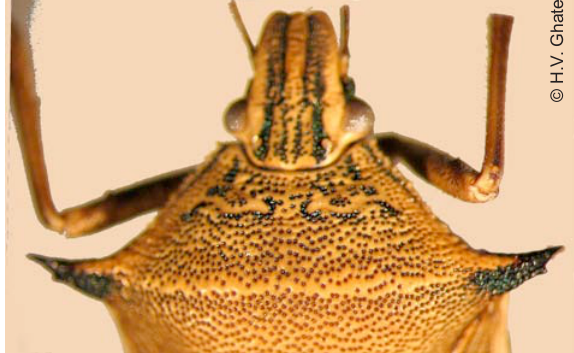
Image 3a. Andrallus spinidens : close up of head and pronotum. Dorsal view showing lateral pronotal spines and impunctate pale line joining the two, crenulations of lateral border and pattern of black punctures near pronotal calli